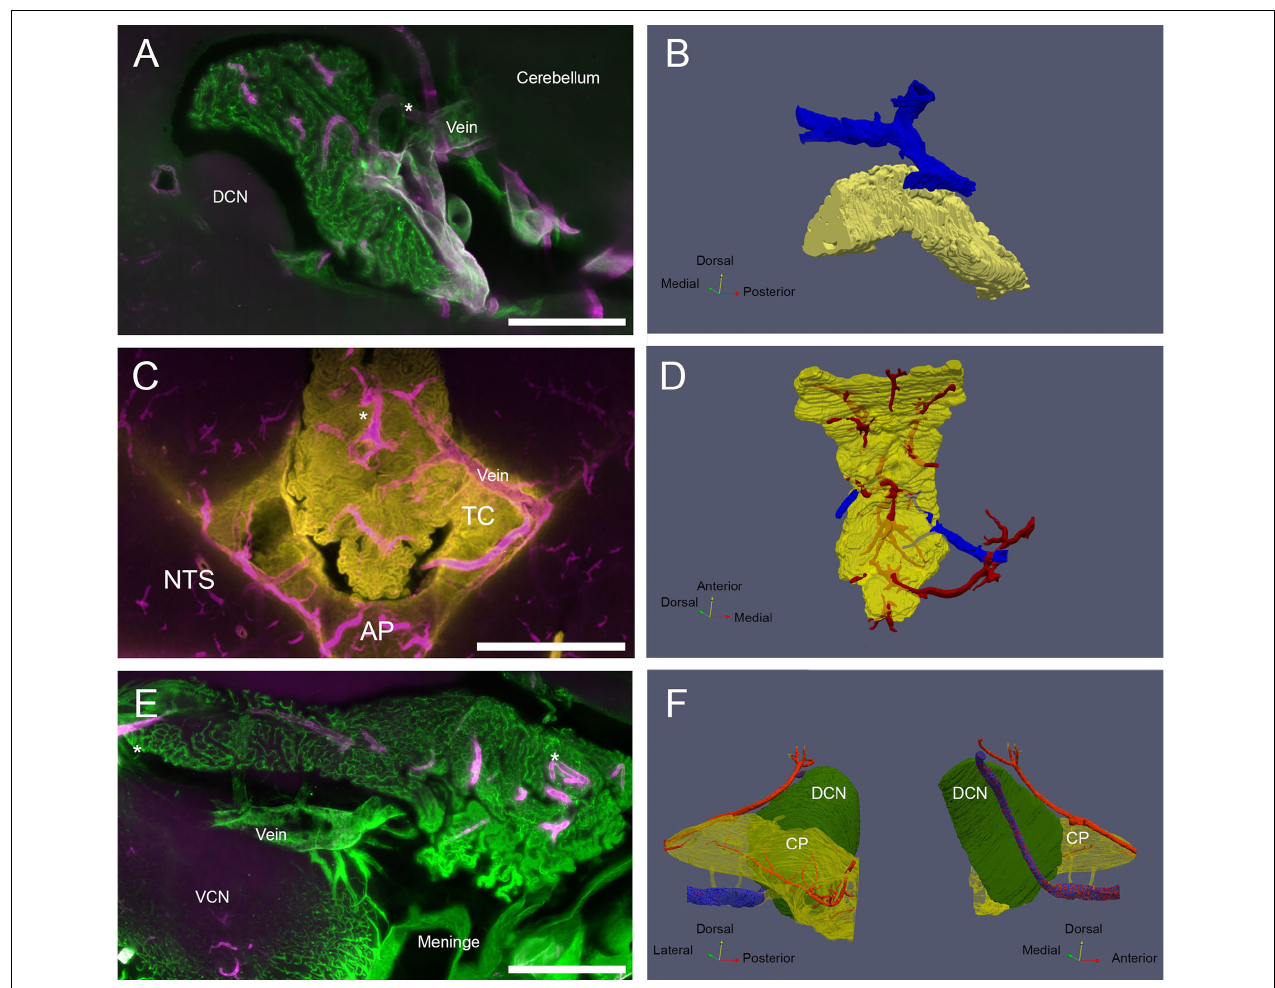
FIGURE 7 | CP veins. (A) View of the MHS vascular arrangement. SMA, magenta; ColIV, green. Scale bar: 500 µ m. (B) Reconstruction of MHS-associated vein. Vein is blue, CP is yellow. (C) View of the CSS venous outflow. SMA, magenta; Notch-2, yellow. Note that Notch-2 labels both CP epithelium and tela choroidea (TC). Scale bar: 1 mm. (D) Reconstruction of CSS-associated vein. Veins are blue, arteries red, CP yellow (semitransparent). (E) View of the LHS vascular arrangement. SMA, magenta; ColIV, green. Scale bar: 500 µ m. (F) Reconstruction of the vein passing under the DCN and emerging associated with Luschka foramen. Vein is shown in stippled blue. Connections to the CP (shown as semitransparent) are shown in yellow. Arteries (red) feeding the DCN and CP LHS are also shown. Both medial and lateral views are shown for